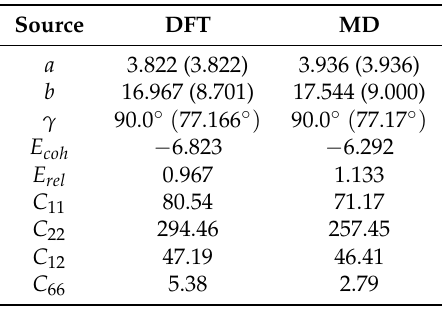
Figure 1. Anisotropic-cyclicgraphene —( a ) conventional and ( b ) primitive cell. Table 1. Lattice parameters of conventional and primitive cell(Å), cohesive energy E coh (eV/Atom), relative energy E rel (eV/Atom) with respect to pristine graphene , and elastic constants C ij (N/m) of Anisotropic-cyclicgraphene